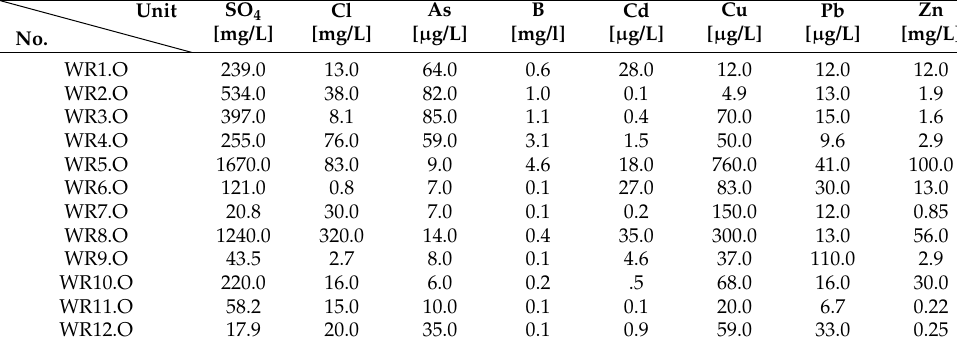
Figure A1. ( A – L ) Presentation of 12 solid waste samples subjected to the leaching process. Table A1. Results of chemical